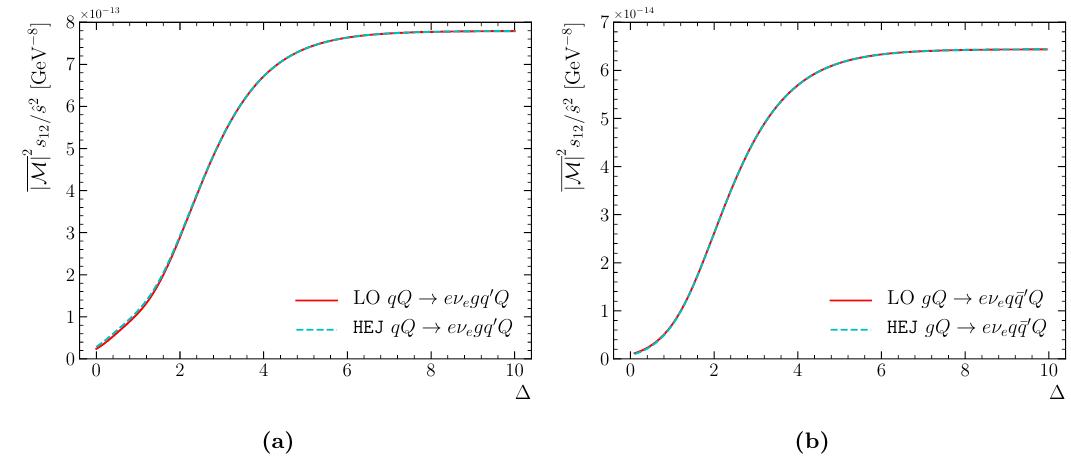
Figure 9. Plots illustrating the scaling of the HEJ approximation at tree-level to the matrix elements (cyan, dashed) for (a) qQ → eν ¯ q 0 Q . The parameter ∆ represents 0 Q , and (b) gQ → eν e gq e q the rapidity separation of the coloured particles as described in the text. Also shown is the leading order result (red, solid). Both cases are seen to obey the expected scaling, eq. (3.24), and further to give a good description of the full LO matrix element across the whole